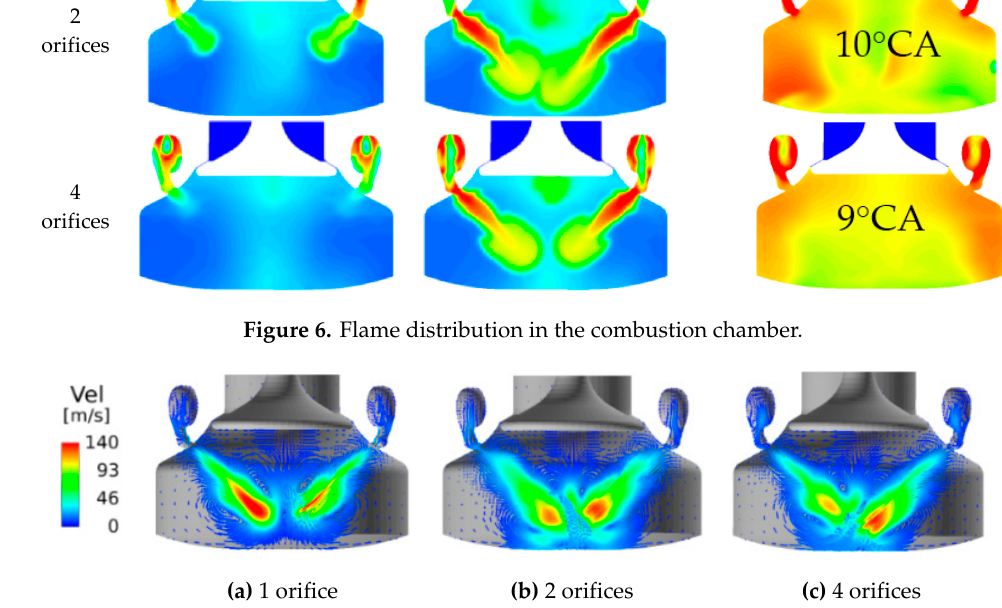
Figure 6. Flame distribution in the combustion chamber.